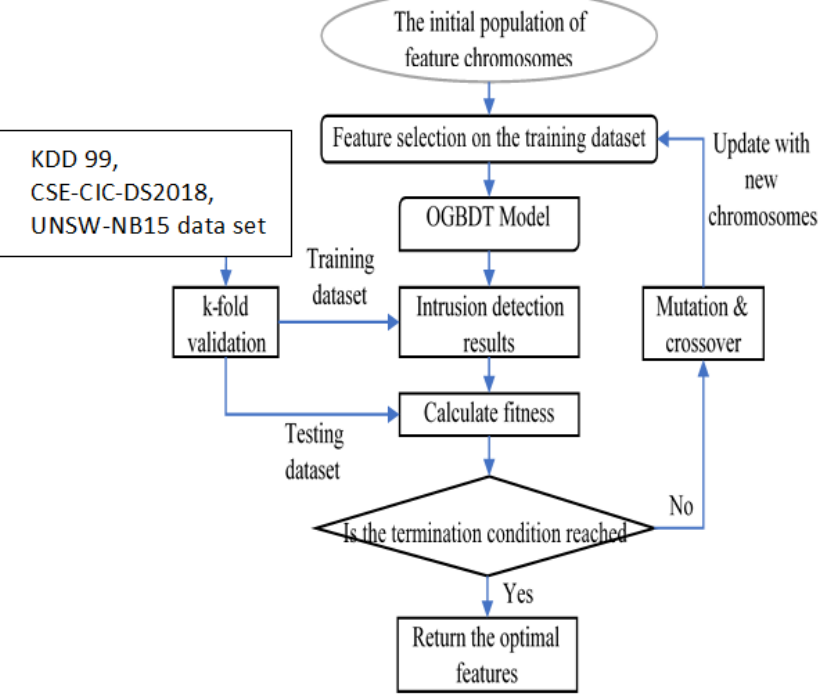
Figure 2. Flowchart of the proposed feature selection process.